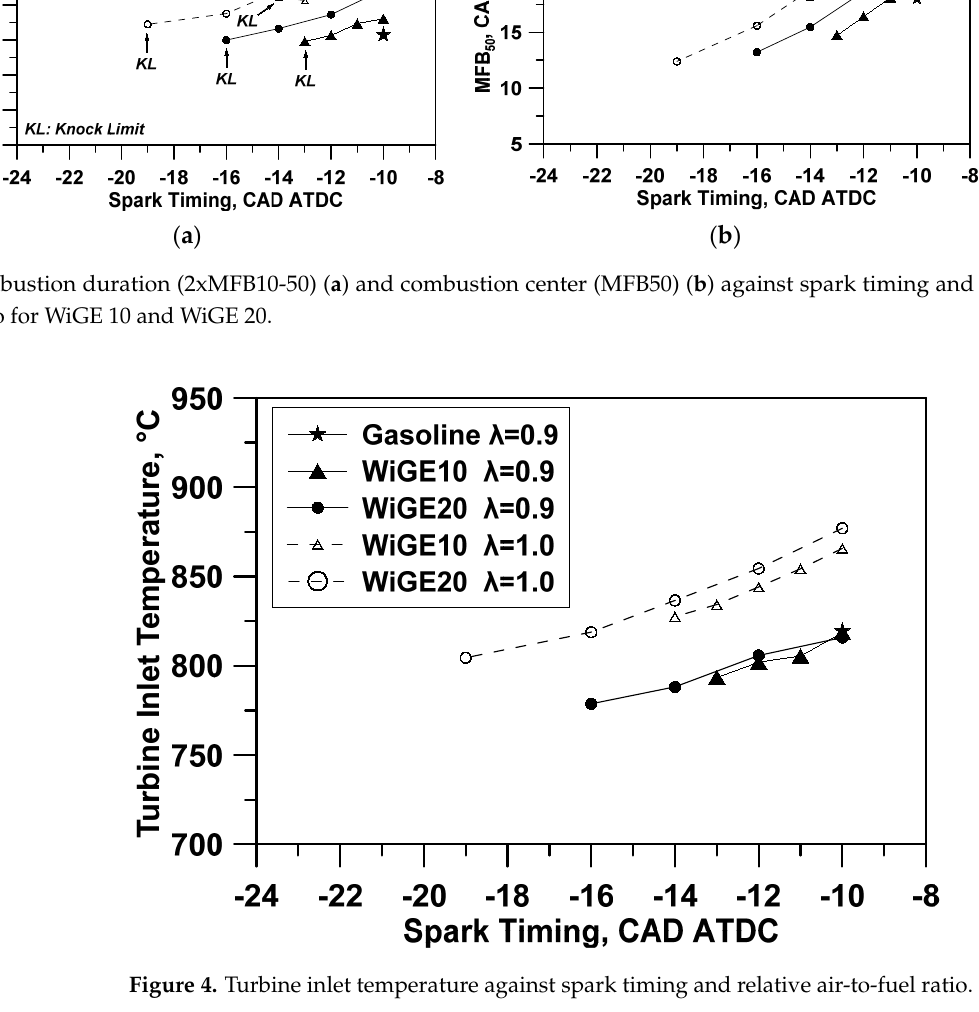
Figure 4. Turbine inlet temperature against spark timing and relative air-to-fuel ratio.